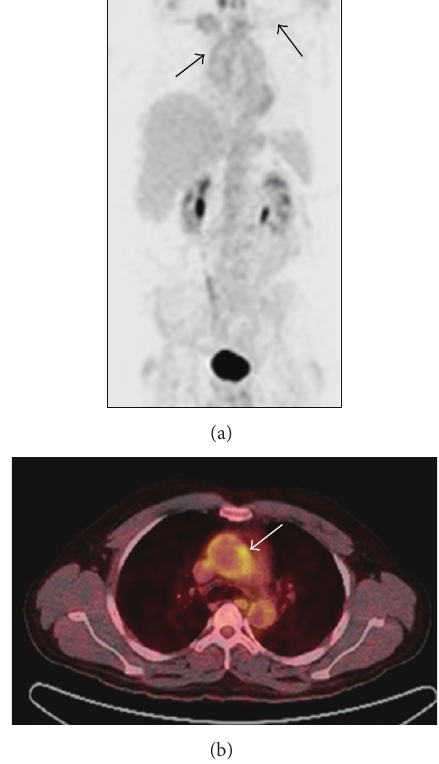
Figure 2: Fluorodeoxyglucose positron emission tomography. (a) An 18 F-FDG-PET scan in a young woman with active Takayasu arteritis demonstrating homogeneous linear uptake of FDG in the arch of the aorta and the subclavian arteries, suggestive of active disease. (b) Coregistered 18 F-FDG-PET-CT image demonstrating increased uptake localised to the wall of the thoracic aorta of a man of 26 years with active